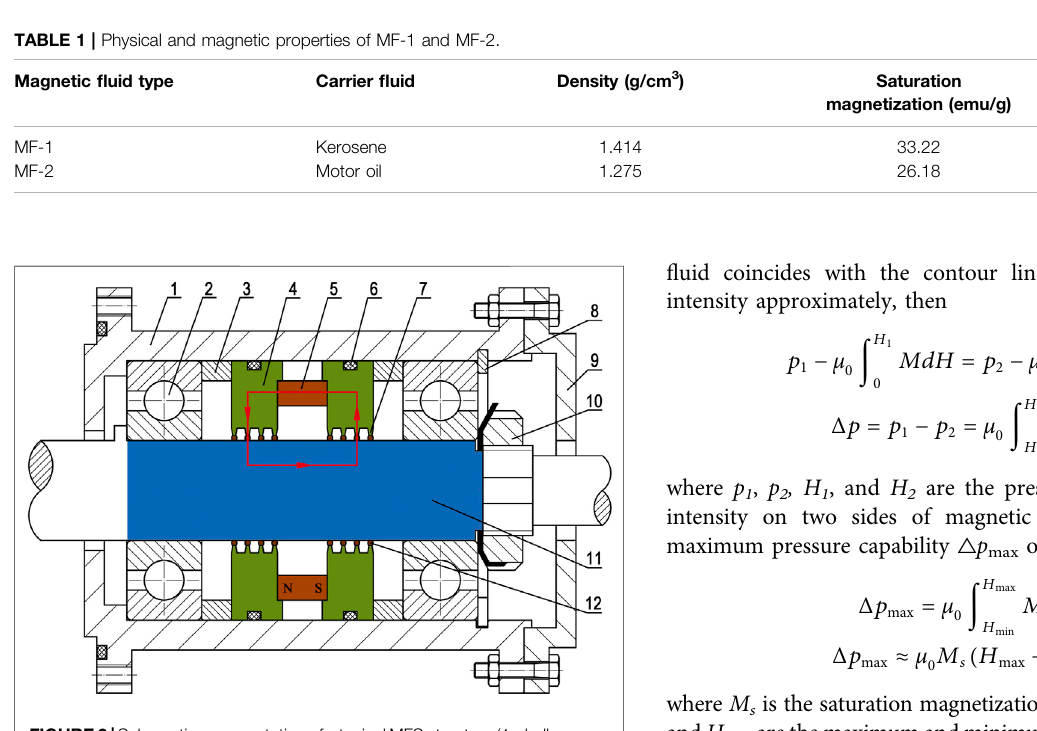
Frontiers in Materials |